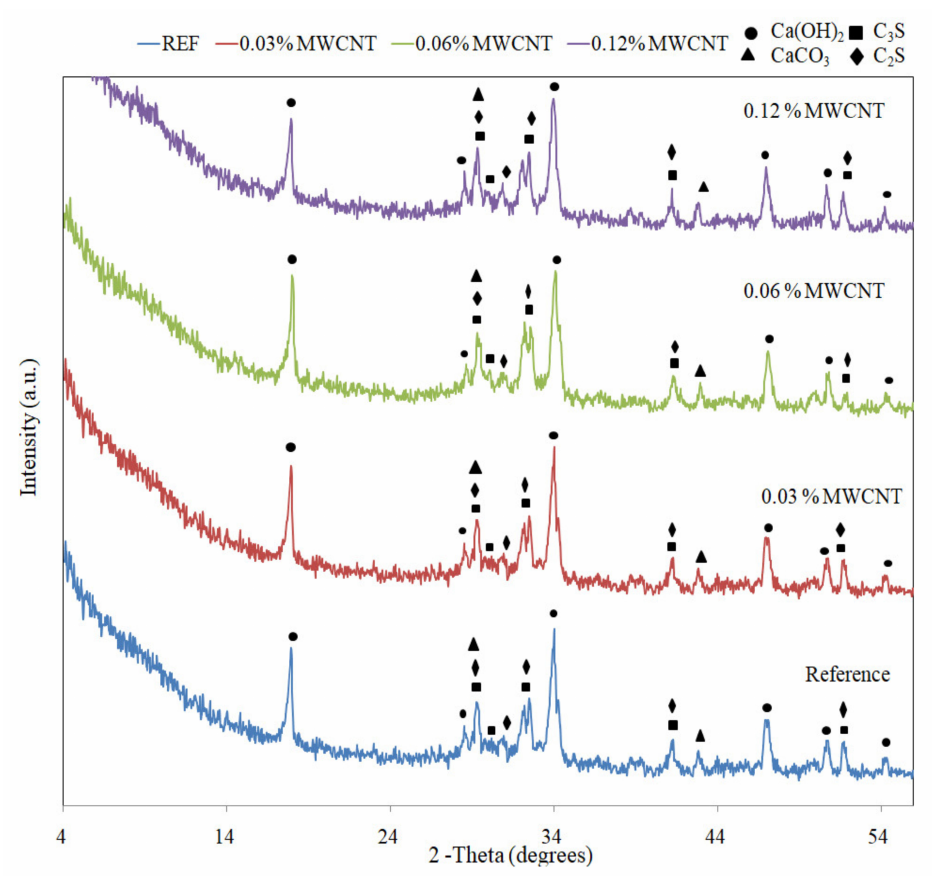
Figure 5. X-ray diffraction patterns of hardened cement paste with nanotubes cured for 28 days under normal